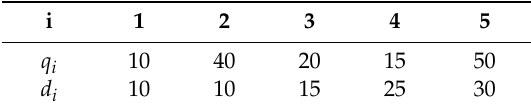
Table 1. Order data for Example 1.